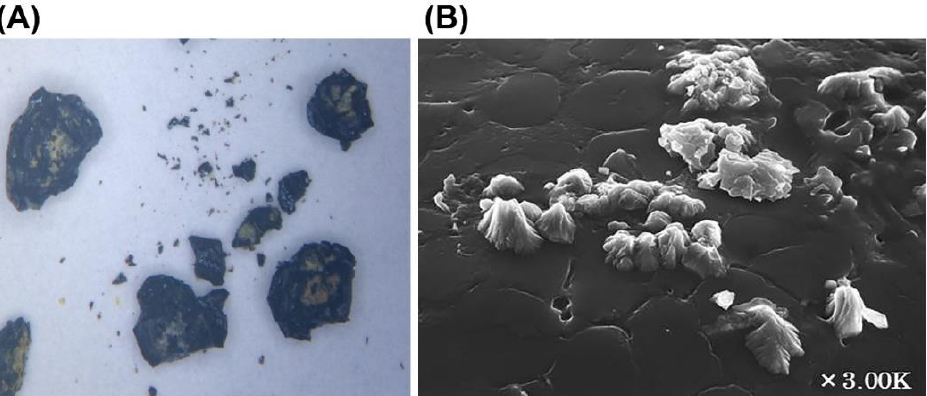
Figure 4. Macroscopic and scanning electron microscopic findings. ( A ), Macroscopic findings of gallstones. Black stones ranging from the size of a grain of sand to 2 to 3 mm. Brownish areas on the irregular surface of the stones. ( B ), Scanning electron microscopic findings ( × 3.00 K). Bacterial colonies were observed on the surface of the